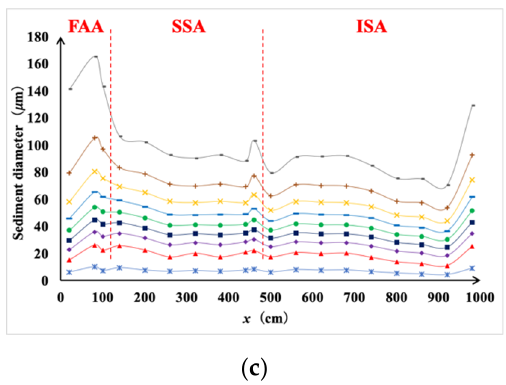
Figure 9. Sediment size grading along the x direction at the tank bottom: ( a ) section of y = 20 cm, ( b ) section of y = 100 cm, and ( c ) section of y = 180 cm.